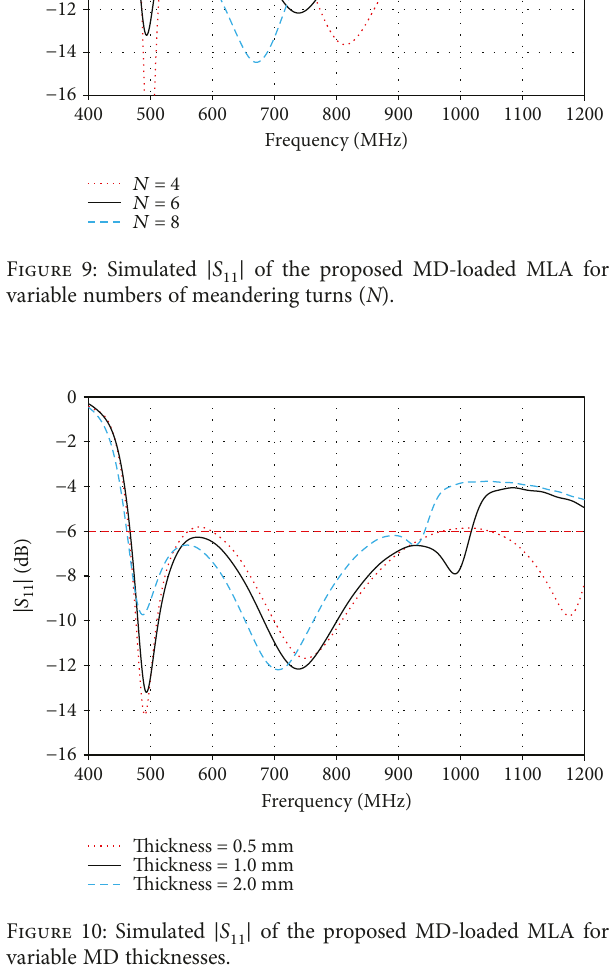
| of the proposed MD-loaded MLA for 11 ). G